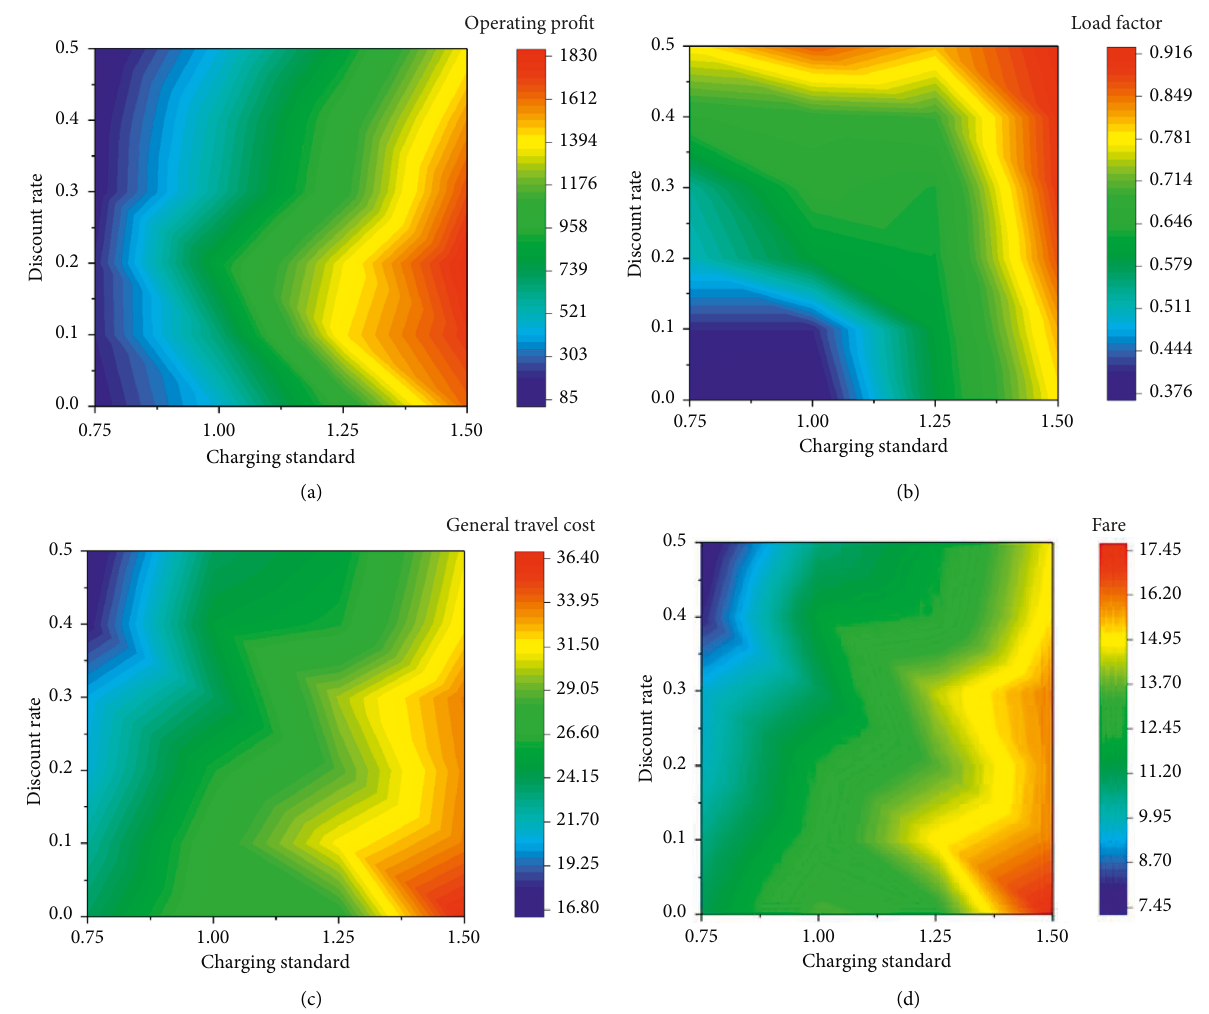
Figure 10: Sensitivity analysis of charging standard and discount rate. (a) Operating profit. (b) Load factor. (c) General travel cost. (d)